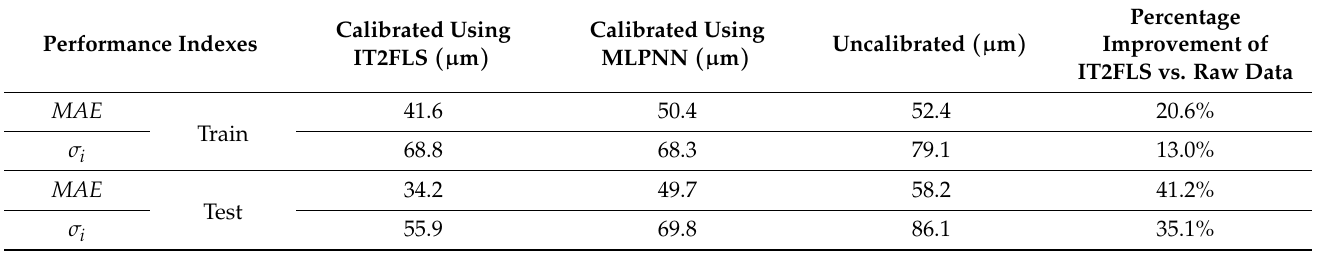
Table 2. XY-mean absolute error and standard deviations of error for the linear